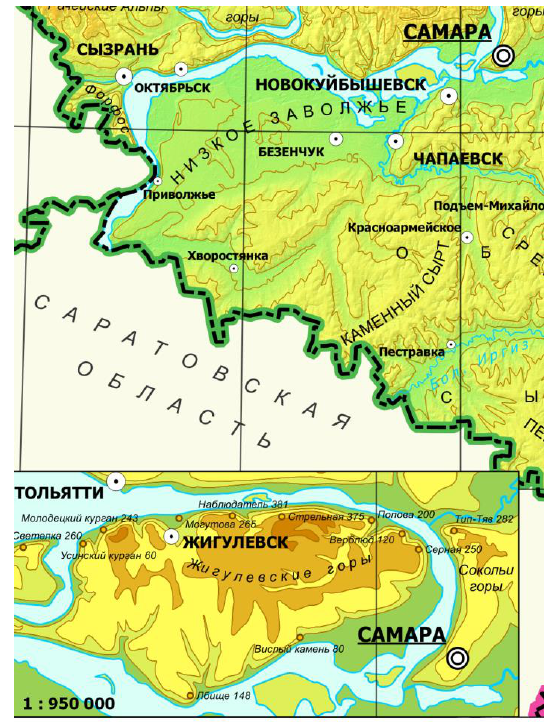
Figure 5. Fragment of the final relief map of Samara Region